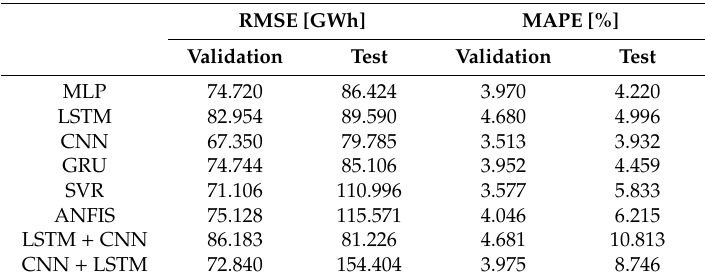
Table 12. RMSE and MAPE Results of Predicted Values for 2